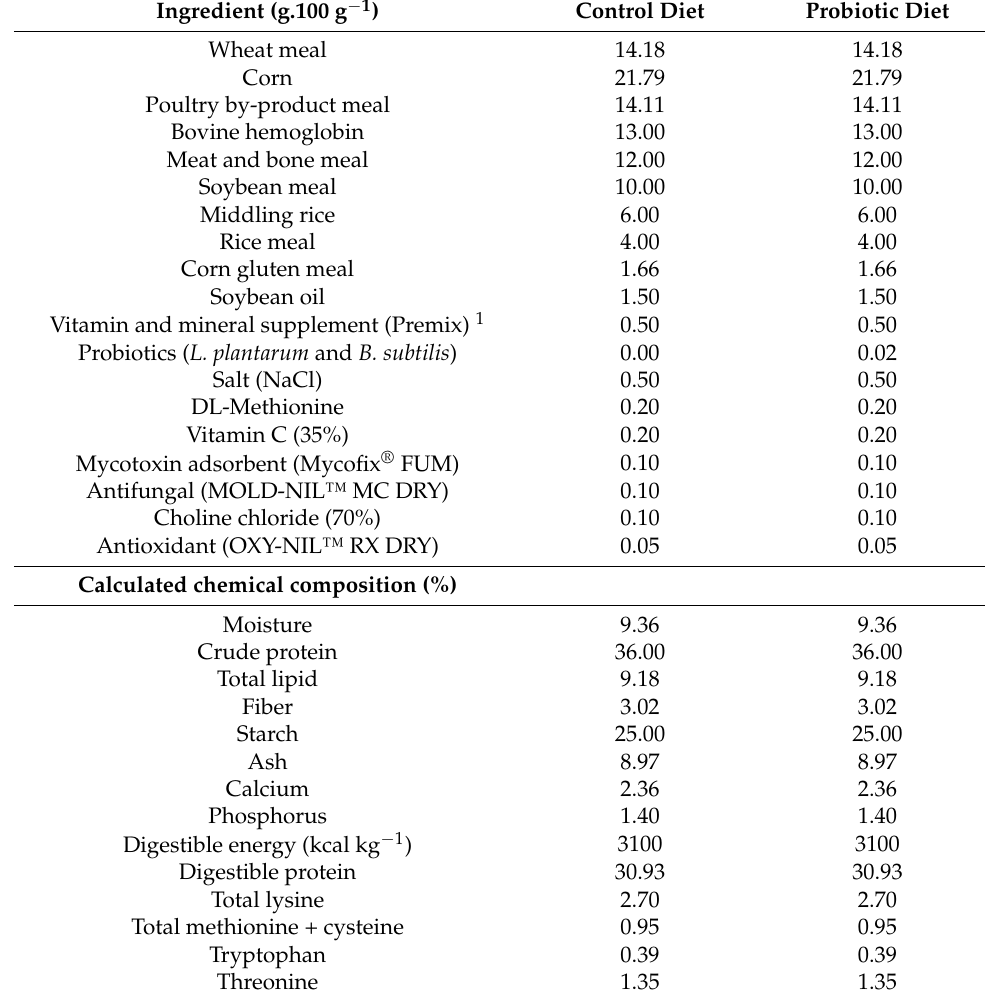
Table 1. Formulation and estimated percentage composition of experimental and control diets of Nile tilapia ( O. niloticus